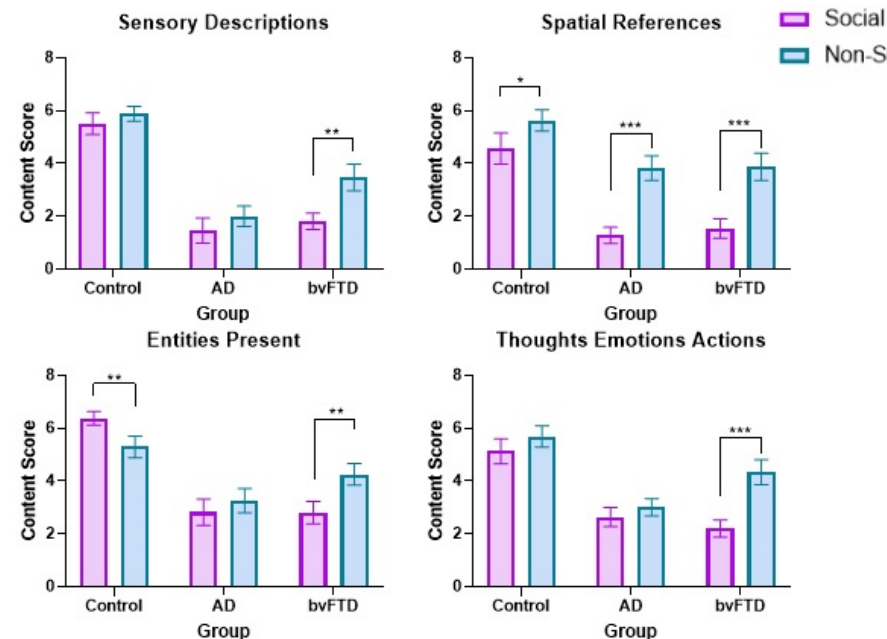
Figure 2. Mean social and non-social scene construction contextual detail scores in the incongruent condition. Whiskers represent standard error of measurement. AD = Alzheimer’s disease. bvFTD = behavioural variant of frontotemporal dementia. * = p < 0.05, ** = p < 0.01, *** = p ≤ 0.0001.